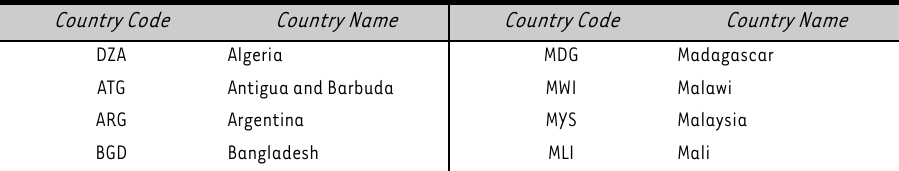
List of emerging and developing countries included in sample (n =